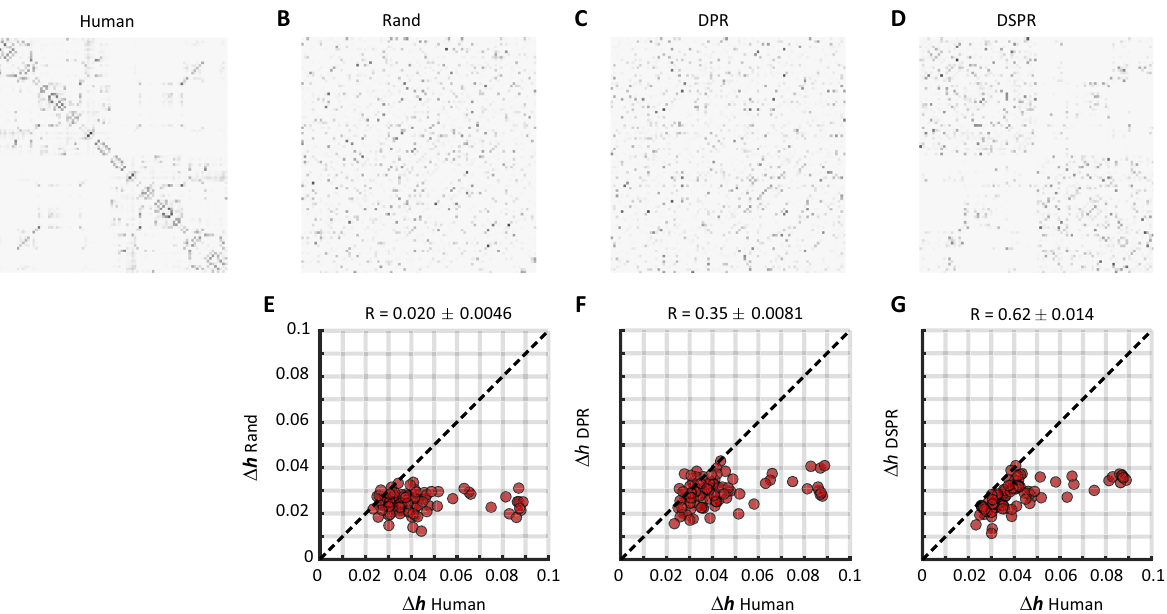
Figure 4. Relative changes in entropy are partially reproduced by a strength-preserving null model of the connectome. ( A – D ) Connectivity matrices used to control the role of local properties of the connectome on (cid:31) h n . See main text for the description of the matrices and randomisation algorithm. ( E – G ) Scatter plots of (cid:31) h n for the human connectome against the three null models. DSPR yielded a high but not perfect correlation showing that local network properties of human connectome are necessary but not sufficient to capture the effect of 5HT2A-R